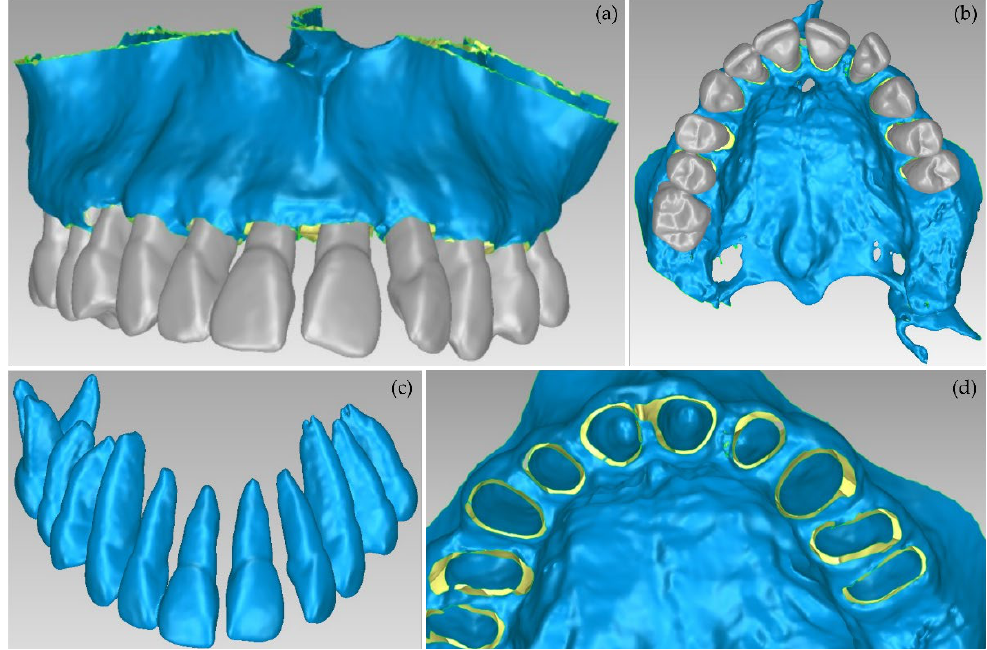
Figure 15. 3D models of teeth and alveolar bone after their processing using the Geomagic Wrap software package (Experiment 4); ( a , b ): alveolar bone and teeth; ( c ): teeth; ( d ): alveolar bone.